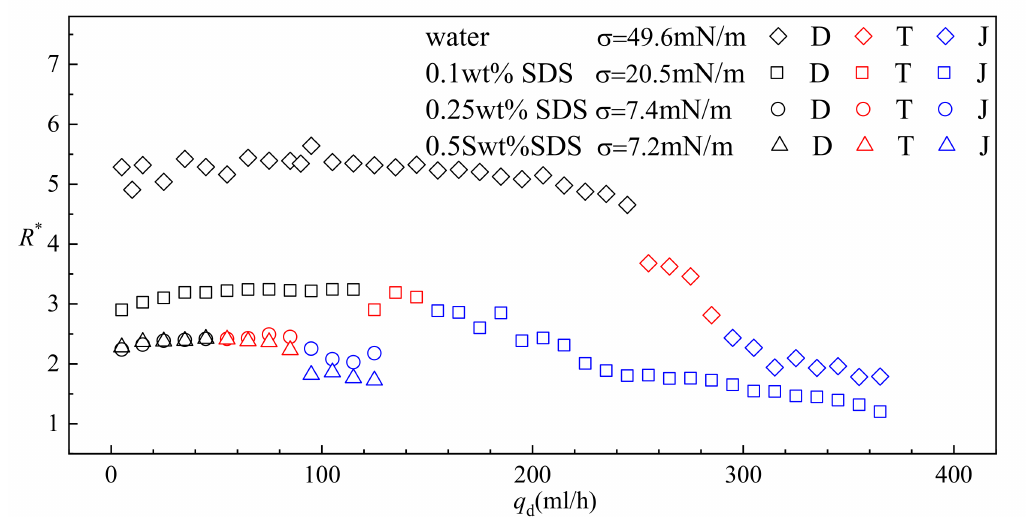
Figure 10. E ff ect of the interfacial tension coe ffi cient on droplet size and formation regimes (D denotes dripping regime, T denotes transitional regime and J denotes jetting